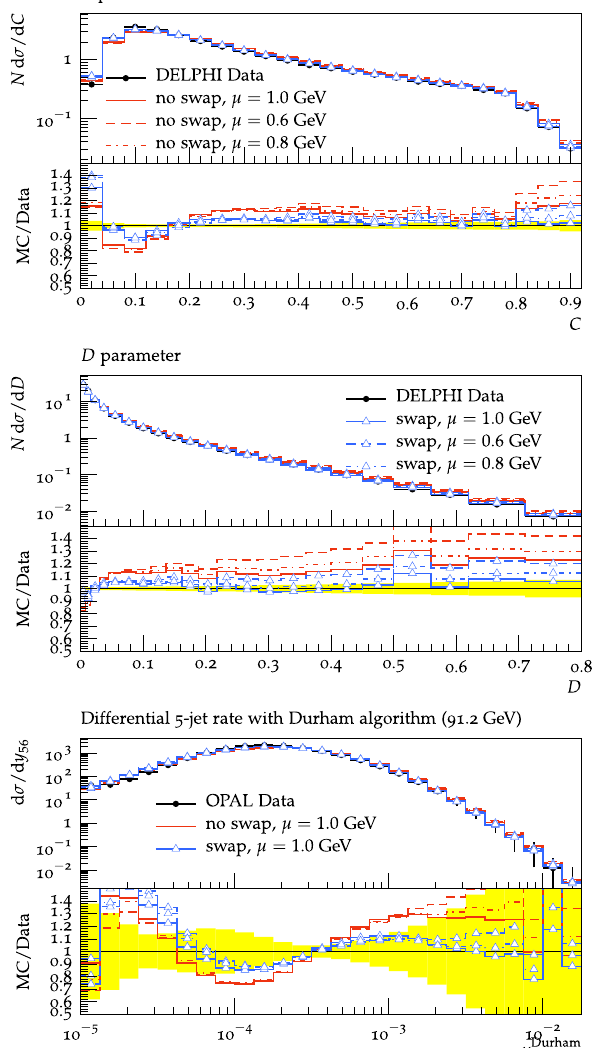
Fig. 3 CandDparameterasmeasuredbyDELPHICollaboration[32]. Differential 5-jet rate as measured by JADE, OPAL Collaboration [33]. For details see Sect.